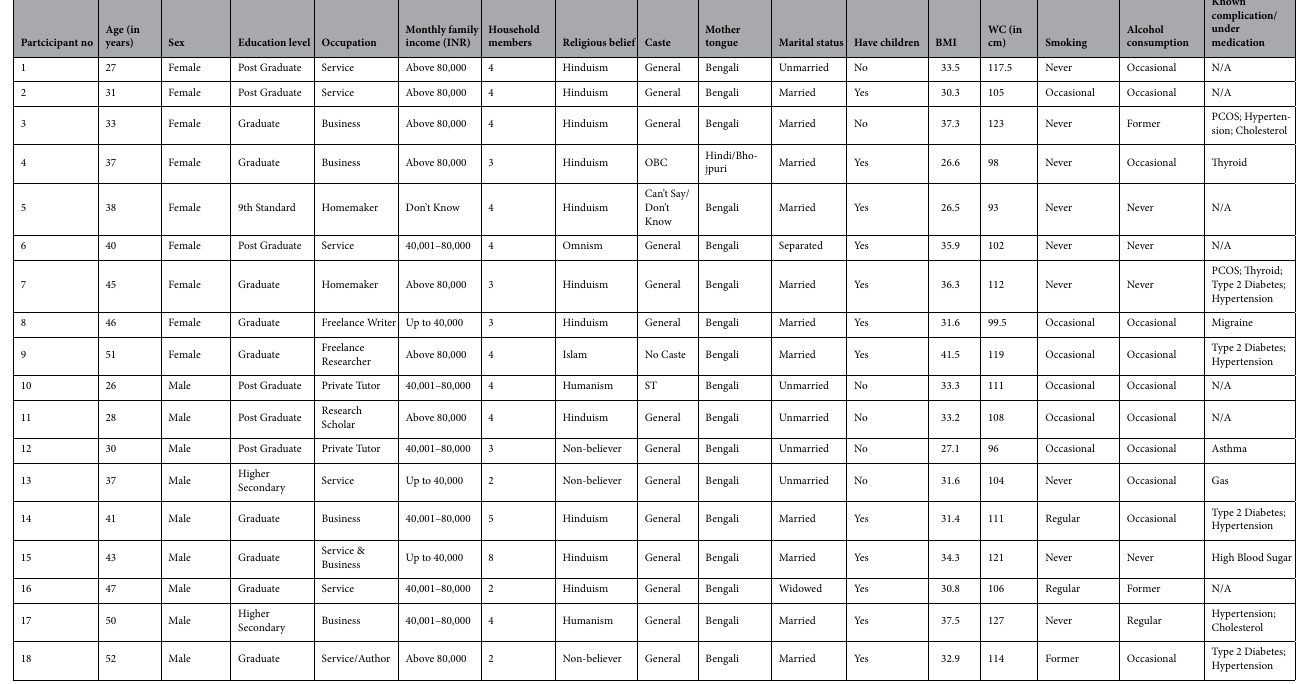
Table 2. Descriptive statistics of the interviewees, Kolkata, 2019–20. Source: Primary